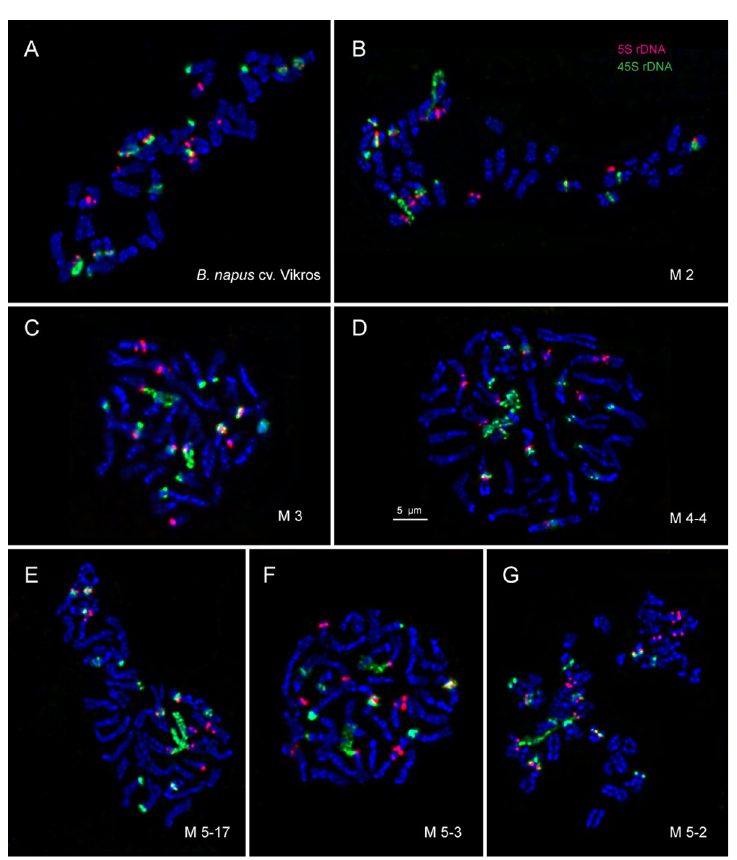
Fig 5. FISH-based localization of 45S and 5S rDNA on chromosomes of B . napus cv. Vikros and M2-M5 mutant plants. Metaphase plates of B . napus cv. Vikros (A), M2 plant of B . napus -type (B), M3 plant of B . rapa- type (C), M4-4 plant of B . rapa -type (D), M-17 plant of B . napus- type (segregated) (E), M5-3 plant of B . rapa- type (F), M5-2 plant of B . rapa- type (G). The correspondent probes and their pseudo-colours are specified in the upper right-hand corner. DAPI-banding (blue). Scale bar– 5 μ